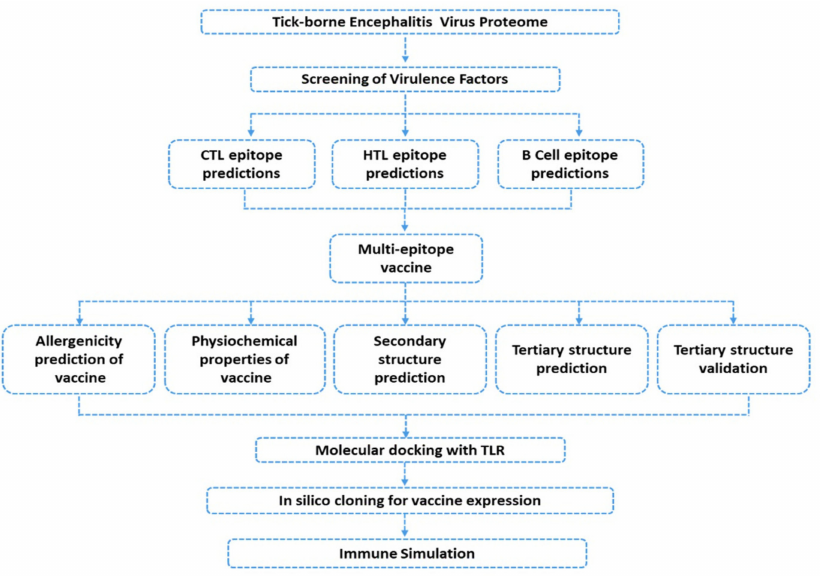
Figure 1. Hierarchical flow of the whole work. Antigenic factors were screened for the CTL, HTL, and B-Cell epitopes prediction. The final vaccine construct was obtained and checked for various properties. In silico cloning and expression was performed to check the efficacy of the final